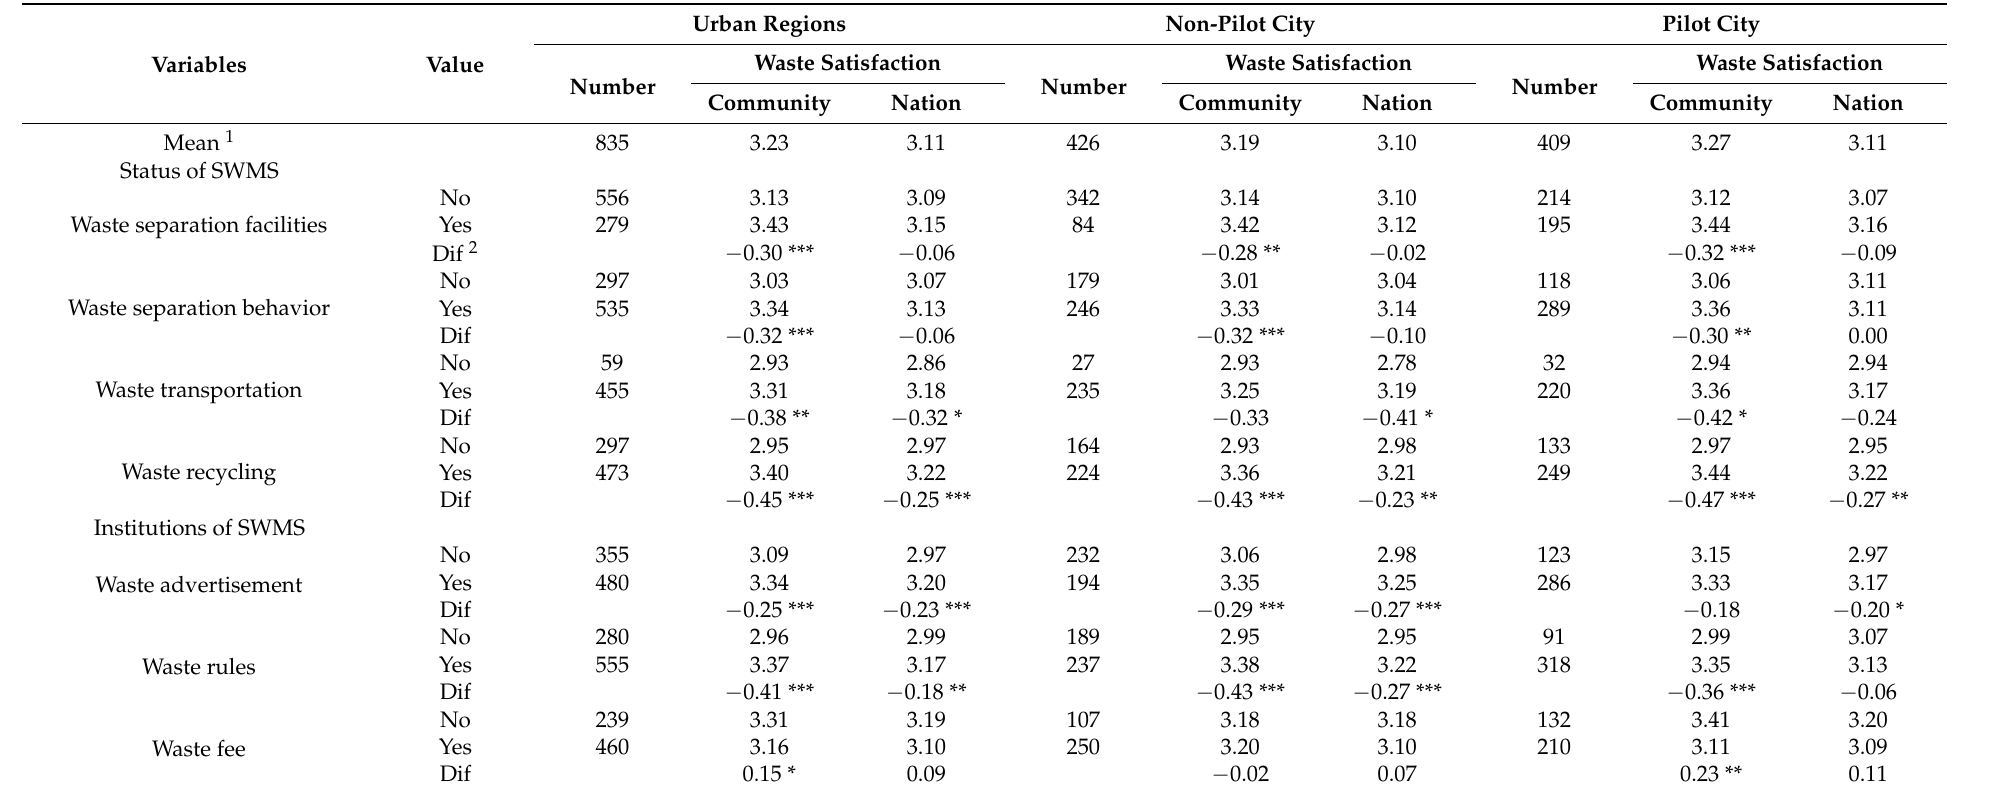
Table A1. Solid waste management services and satisfaction with community and national SWMS among non-pilot and pilot cities in urban China. Urban Regions Non-Pilot City Pilot City Waste Satisfaction Waste Satisfaction Waste Satisfaction Variables Value Number Number Community Nation Community Nation Community